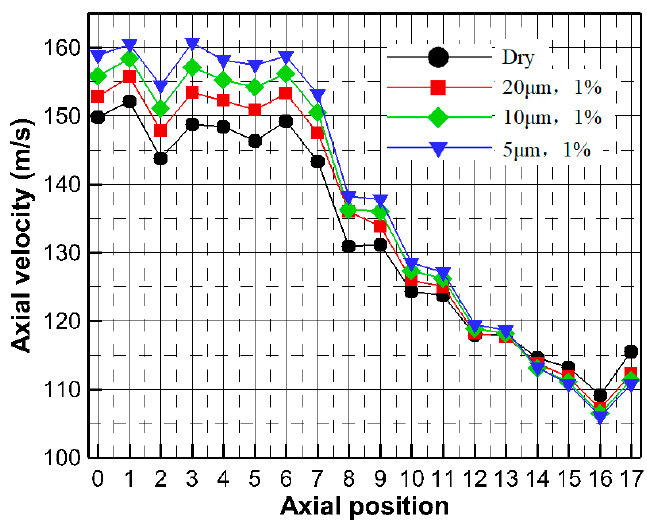
Figure 32. Axial variation of gas density under water of different injecting rates.